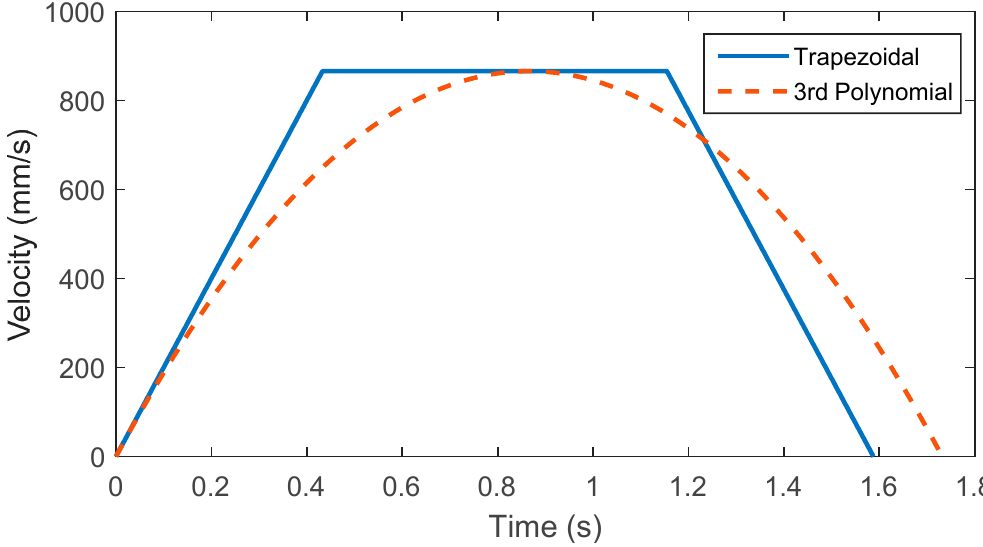
Figure 1. Comparison of trapezoidal motion profile and 3rd-order polynomial trajectory with the same maximum velocity and acceleration.